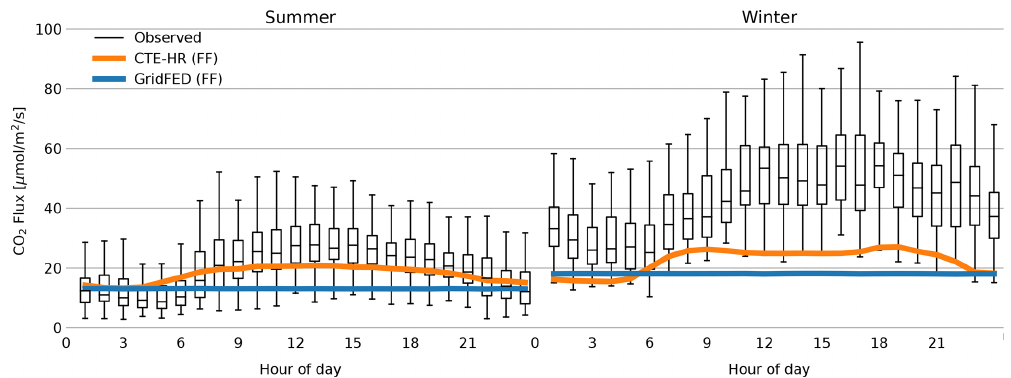
Figure 9. Average fluxes per hour of the day for the summer (MJJA) and winter (ND) of 2018 over Amsterdam. The box plots show the observed fluxes. Orange shows the Amsterdam emissions as calculated by our CTE-HR model, averaged over four grid boxes over Amsterdam (52.3 ◦ N, 4.6 ◦ E to 52.5 ◦ N, 4.8 ◦ E). The blue line shows the GridFED emissions (Jones et al., 2021), averaged over the same area as the CTE-HR emissions. September and October are not included in this figure, as there are large gaps in the observations in these months. Also, the first months of the year are missing, as the measurements started in May